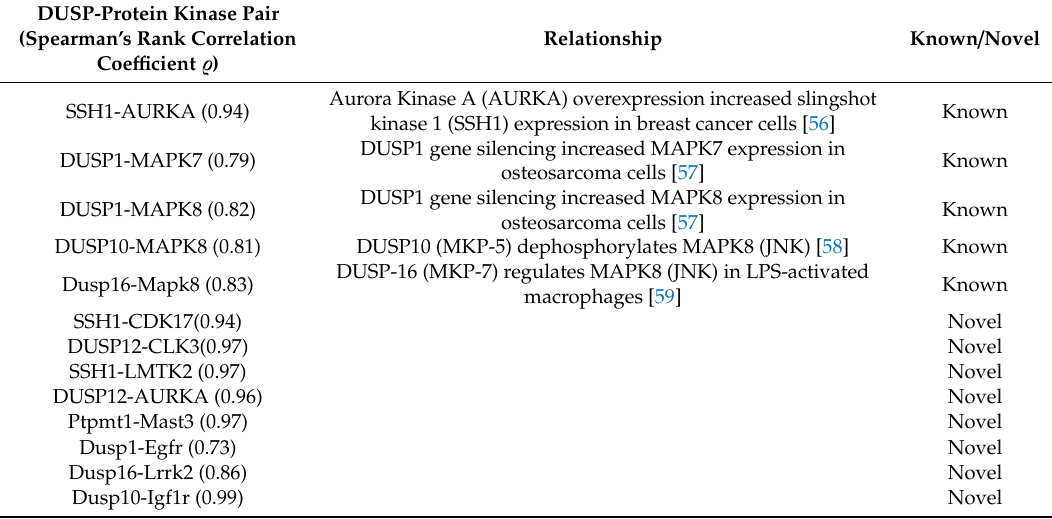
Table 1. A table summarizing representative known and potentially novel human and murine DUSP-kinase pairs with reciprocal